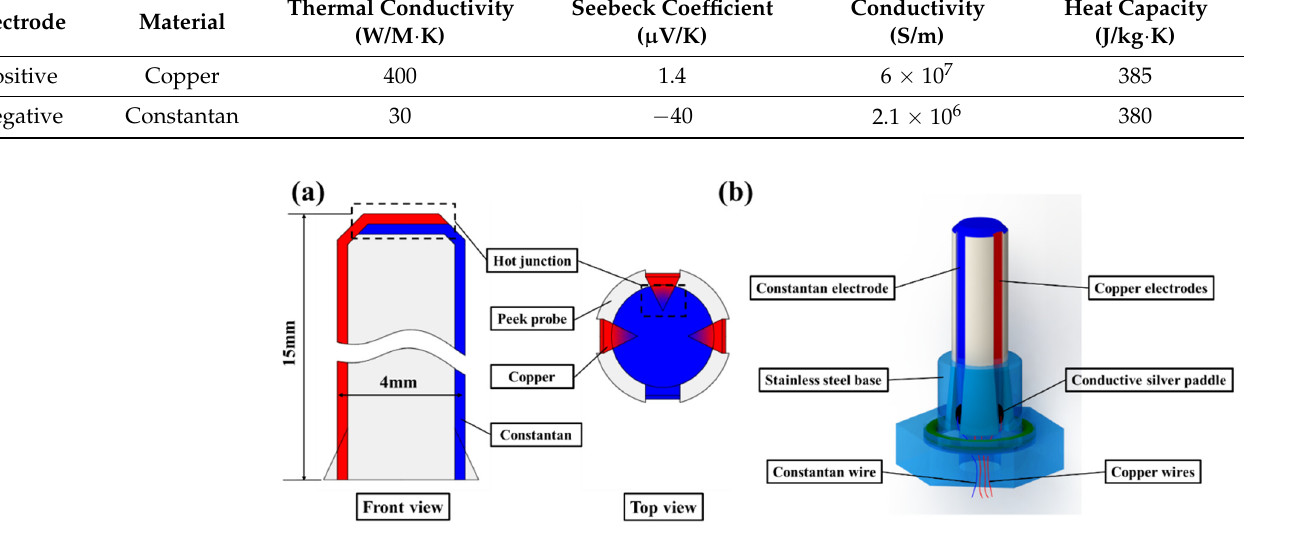
Figure 2. ( a ) Section diagram and ( b ) 3D schematic diagram of the sensor structure.